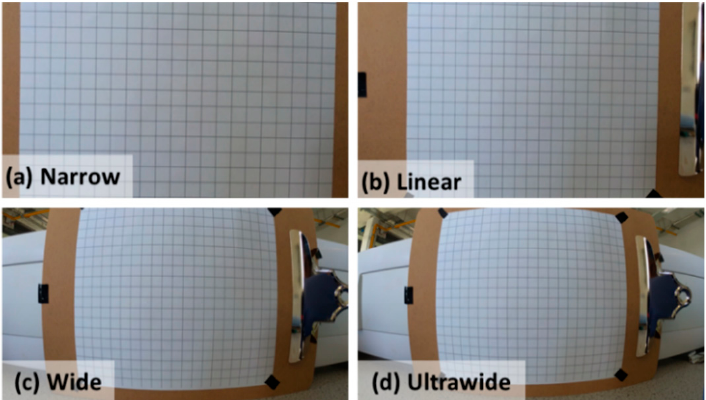
Figure 15. Insta360 One R FOV options.